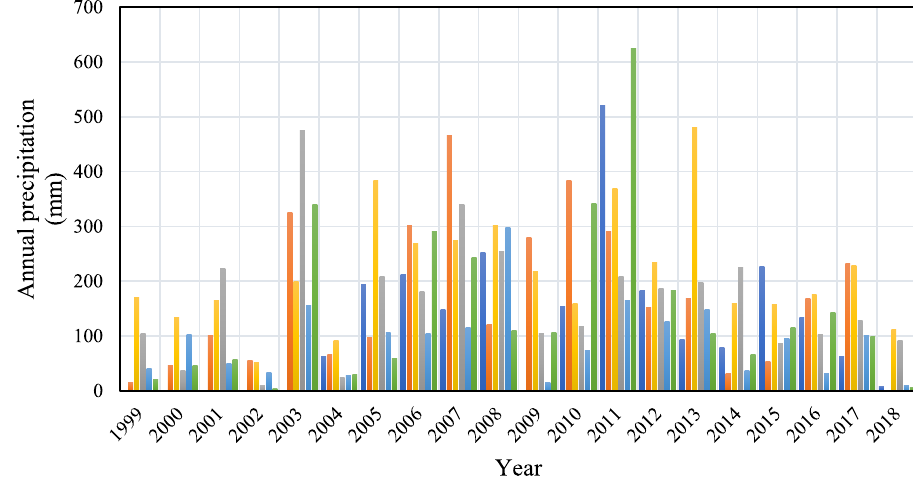
Fig. 6 Annual precipitation (mm) of neighboring mete- orological stations